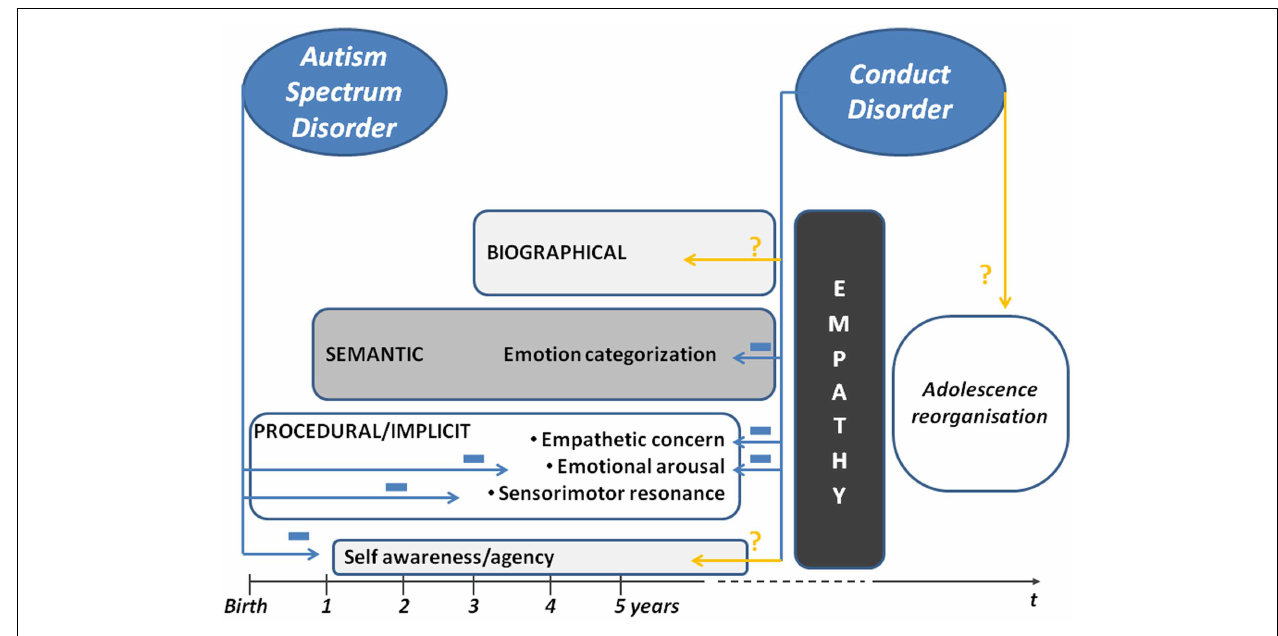
FIGURE 1 | Development of empathy in early childhood